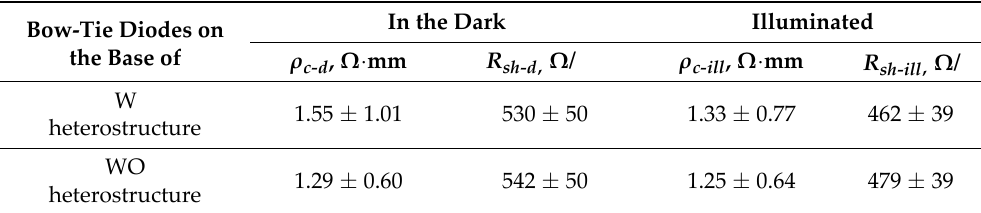
Table 2. Specific contact resistance of the bow‑tie diodes and sheet resistance of the selectively doped W and WO semiconductor structures in the dark and under visible light